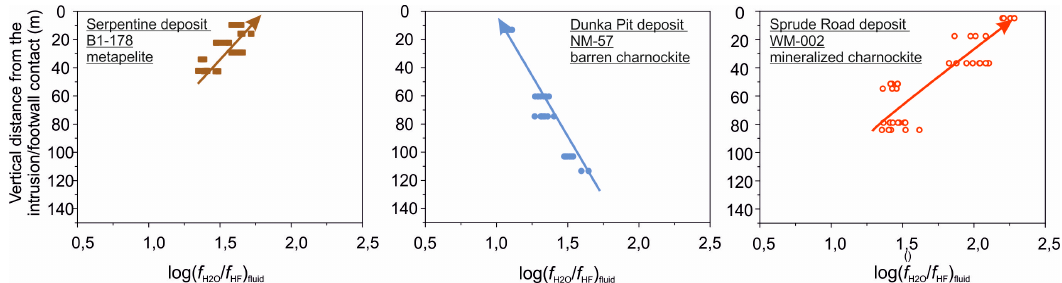
Figure 11. Variation of log( f H2O / f HF ) fluid calculated on the basis of biotite halogen ratios as a function of depth in the footwall section of the studied drill cores. The top of the plots coincides with the intrusion-footwall contact. Note that the log( f H2O / f HF ) fluid increases only in the barren NM-57 drill core, i.e., with increasing depth, the fugacity of F decreases. In the mineralized drill cores, the decreasing log( f H2O / f HF ) fluid suggests increasing F fugacity in the distal part of the footwall.